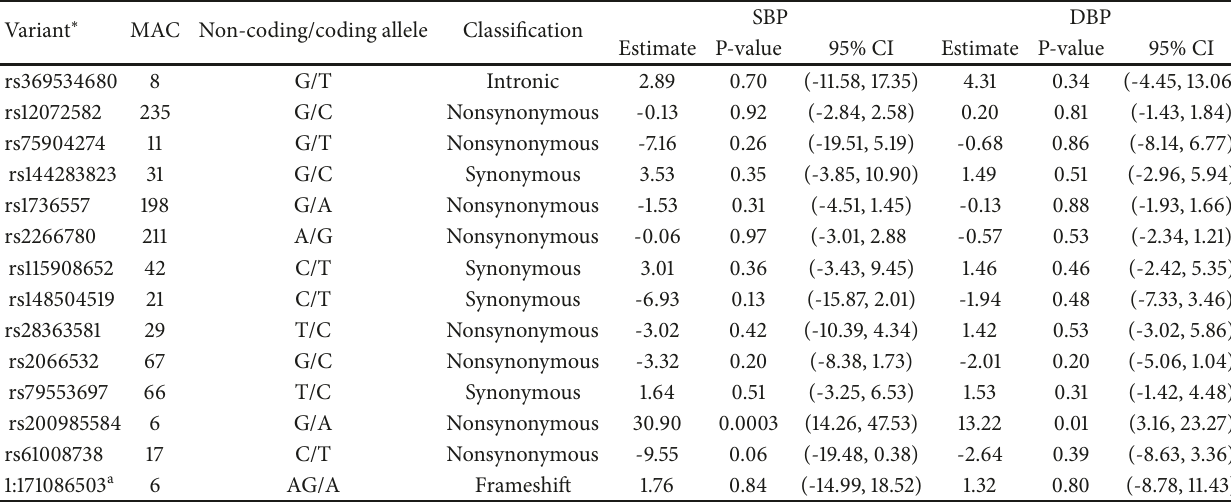
Table 4: Results from low-frequency single-variant analysis of FMO3 with SBP or DBP as outcomes in African Americans. Variant ∗